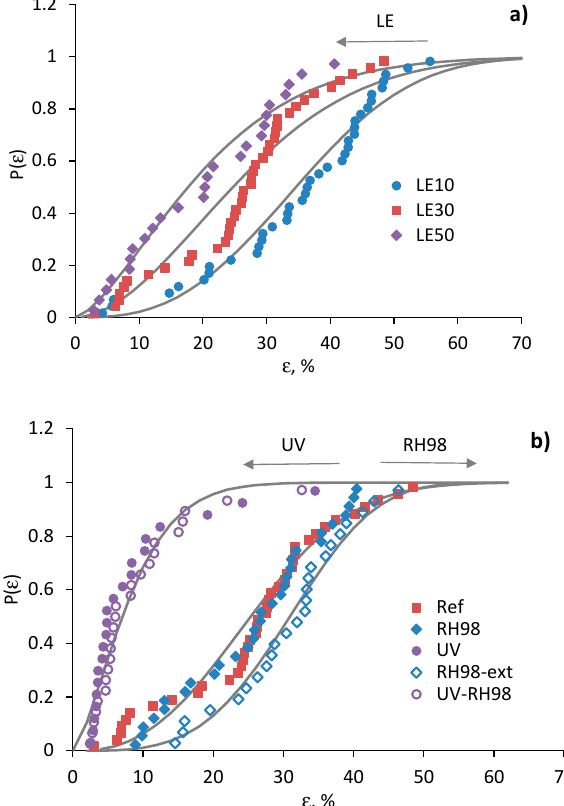
Figure 13. Failure strain distribution of the reference fibers of different gauge lengths ( a ) and fibers from different environments with an LE = 30 mm ( b ). Lines are calculations by Equation (5).